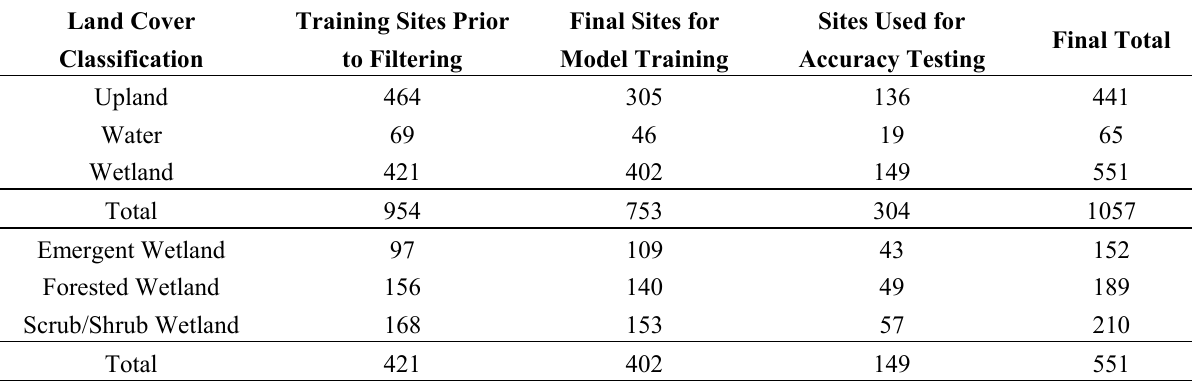
Table 2. Summary of reference point data before and after the filtering of training